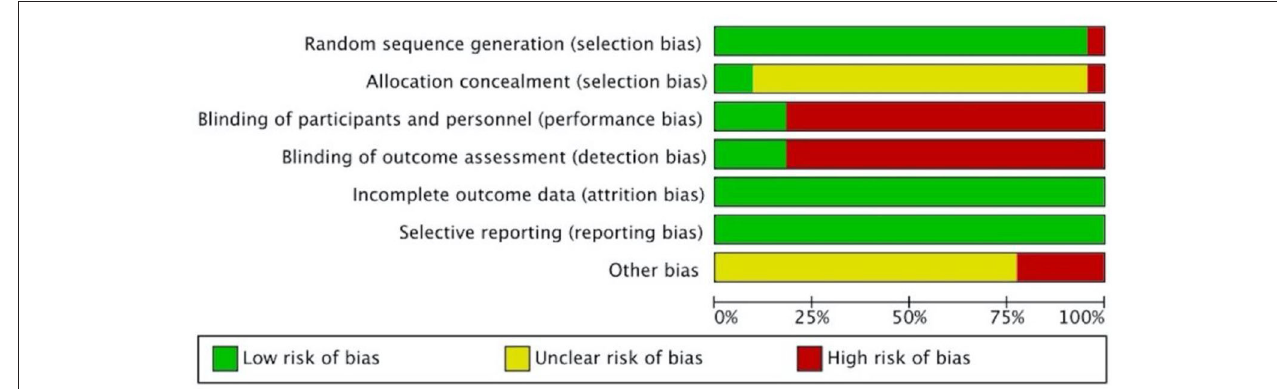
FIGURE 2 | The overall risk of bias assessment using the Cochrane Collaboration’s tool.